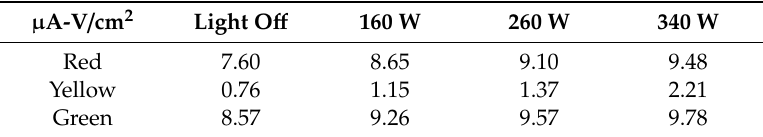
Table 2. Integral values of cyclic voltammetry (CV) graphs for red QDs, yellow QDs, and green QDs, respectively.